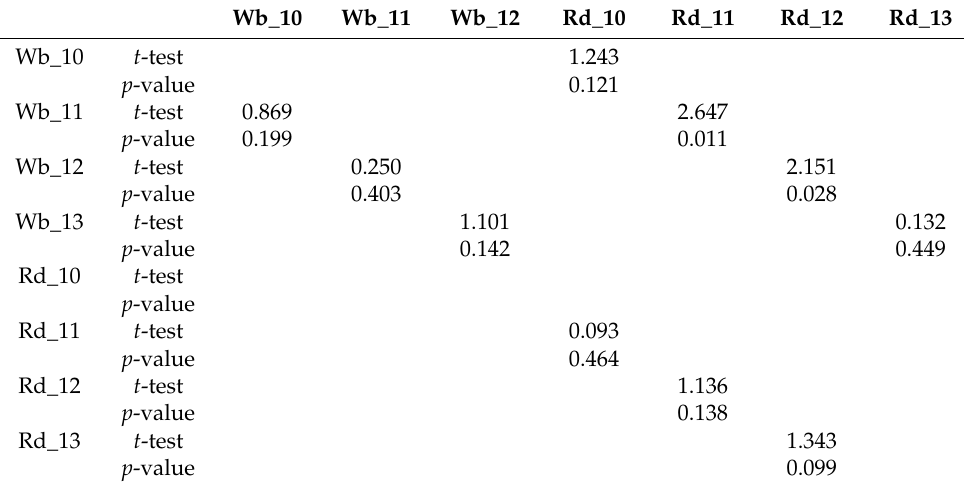
Table 2. Results of the Student’s t -tests for the period 2010–2013.